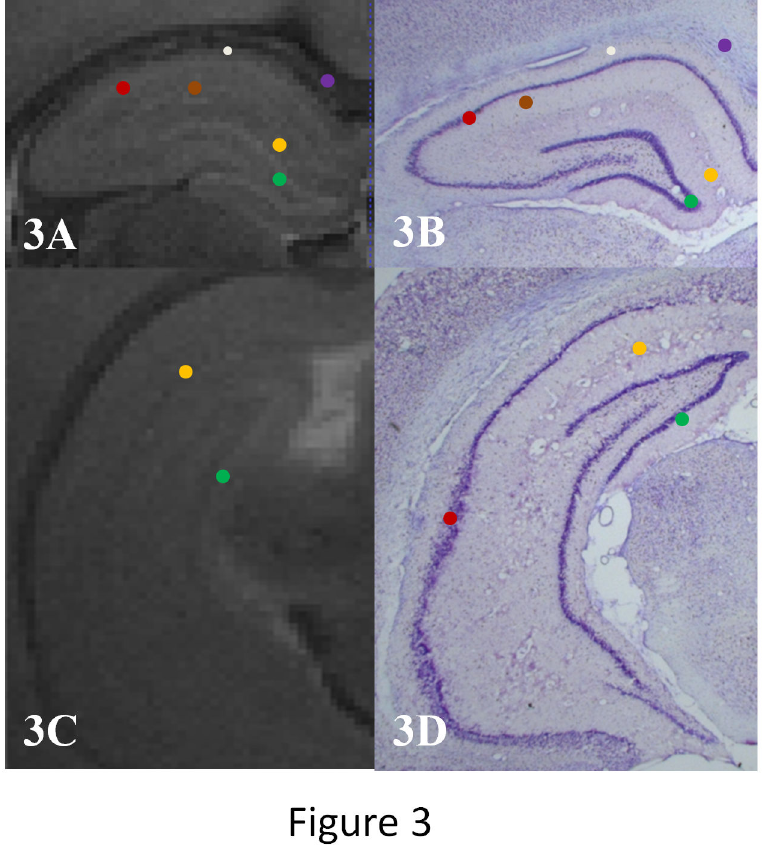
Figure 3. MRI and histological hippocampal sub-layers comparison. Comparison of T2-weighted images of the dorsal hippocampus (A) and ventral hippocampus (C) and cresyl violet’s histological slices (B and D). White dot: stratum oriens, Red: CA3 stratum pyramidale, Brown: stratum radiatum , Yellow: CA1 stratum lacunosum and DG stratum moleculare ,Blue: stratum moleculare of the dentate gyrus, Green: stratum granulare of the dentate gyrus, Purple: Corpus callosum.